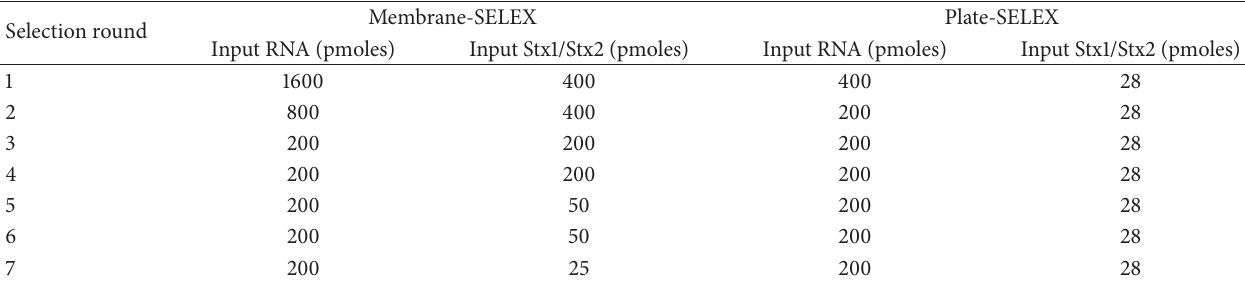
Table 1: Concentrations of RNA aptamer pool and Stx1 or Stx2 for SELEX